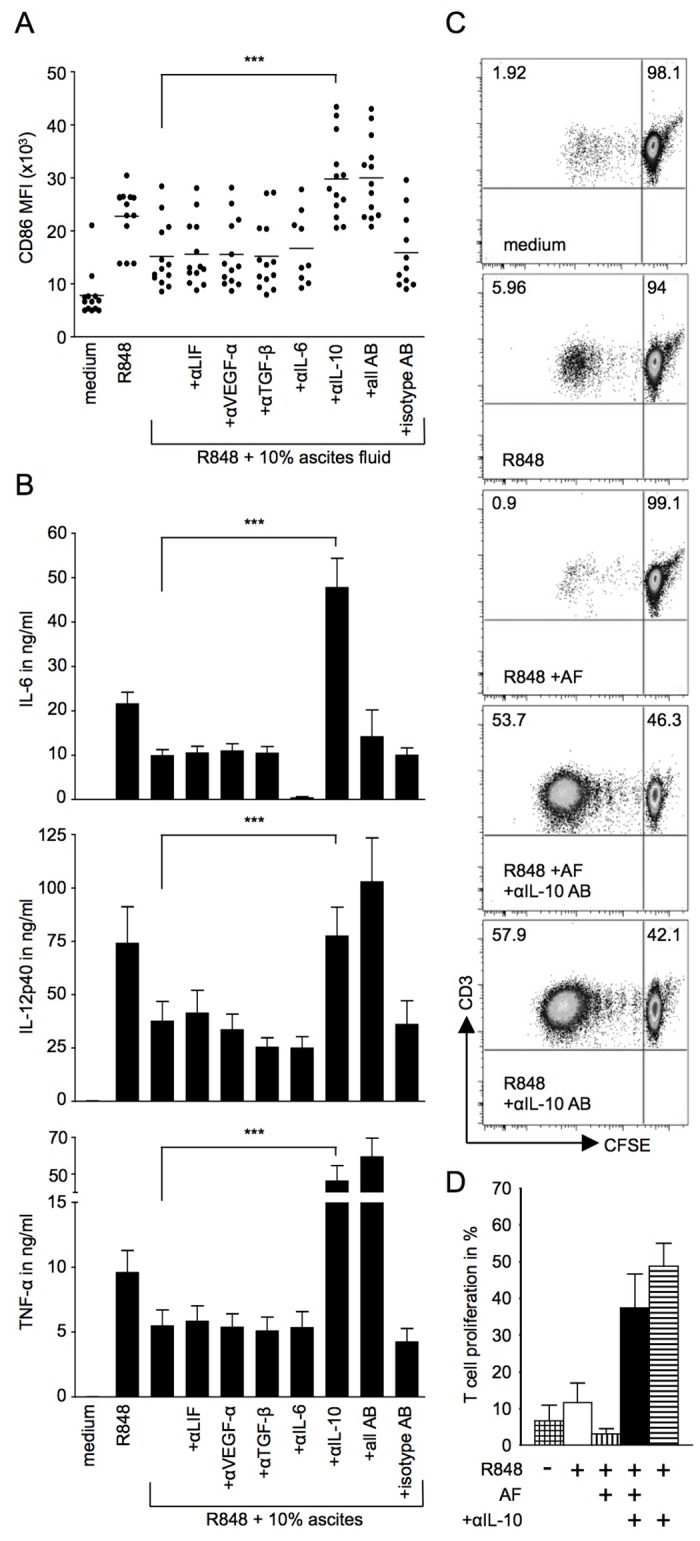
Neutralisation of IL-10 releases the impairment of DC activation in response to TLR stimulation in the presence of OC-associated ascites.(A, B) Monocyte derived DC were cultured in the presence of 3μg/ml R848, 10% ascites and neutralizing antibodies (5μg/ml) as indicated. Neutralizing antibodies were added to cultures alone or in combination. (A) CD86 expression levels were measured by flow-cytometry, and (B) cytokine levels were measured in cell culture supernatants by flow cytomix analysis (IL-6, TNFα) or sandwich ELISA (IL-12p40). n = 9–13 (13 independent experiments; monocyte-derived DC from 8 different healthy donors, cultured with 1 (n = 4), 2 (n = 3) or 3 (n = 1) different ascites samples. IL-6 neutralizing antibody was only used in 9 out of 13 experiments). One-way ANOVA (Friedman test with Dunn post test): *** = p<0.001. Please note that the quantification of IL-6 in samples containing IL-6 neutralizing antibody (αIL-6 and all AB) is compromised. (C, D) For allogeneic MLR, monocyte-derived DC from healthy donors were cultured overnight in complete medium only, or stimulated with 3μg/ml R848 in the presence or absence of 10% ascites fluid (AF) and/or IL-10 neutralizing antibody (5μg/ml) as indicated. Subsequently, such pre-treated DC were washed and co-cultured with CFSE-stained CD4+ naïve T cells from another healthy donor at a 1:200 ratio for 6 days. Naïve T cells from the same donor were used consistently for all experiments. The proliferation of T cells was determined by CFSE dilution after 6 days. (C) A representative example of flow-cytometry analysis is shown. (D) Cumulative data from 4 independent experiments showing proliferation in percent of CD3+ cells that have undergone at least one round of division. n = 4 (4 independent experiments; monocyte-derived DC from 3 different healthy donors, cultured with ascites from two (n = 1) or one (n = 2) OC patient).